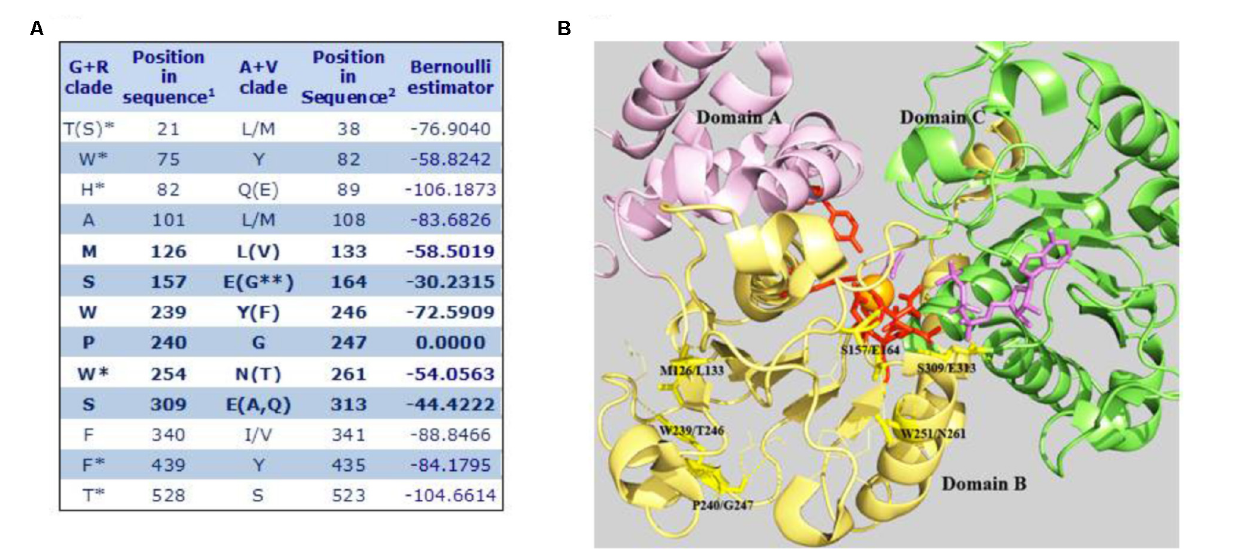
FIGURE 5 | Specificity-determining position in MEs of the A+V and R+G clades. (A) 1 Amino acid positions in the primary sequence of α mNAD-ME from A. thaliana . 2 Amino acid positions in human mNAD-ME. Residues between parentheses show a frequency of occurrence lower than 10%. Residues on the right side of bars show a frequency of occurrence higher than 10%. ∗ Corresponds to SDPs identified only when embryophyte G+R sequences were compared with all A+V groupings. ∗∗ Corresponds to one residue found only in plastidic NADP-ME from Setaria italica. Letters in bold indicate SDPs with the highest z-scores that were defined as signature residues. (B) The SDPs with the highest scores are mapped onto the three-dimensional structure of the human mNAD-ME complex with the L -malate analog (oxalate, in magenta), NAD + (in magenta), Mn + 2 (in orange), and fumarate (not shown; 1GZ3, Yang et al., 2002). Signature residues are shown as stick yellow lines. Residues involved in L -malate binding and catalysis are shown as stick red lines. Residues contacting signature residues are shown as fine lines. Domains A, B, and C are shown in different colors. For clarity, whole Domain D and the α B3-helix of Domain B were omitted in the model.